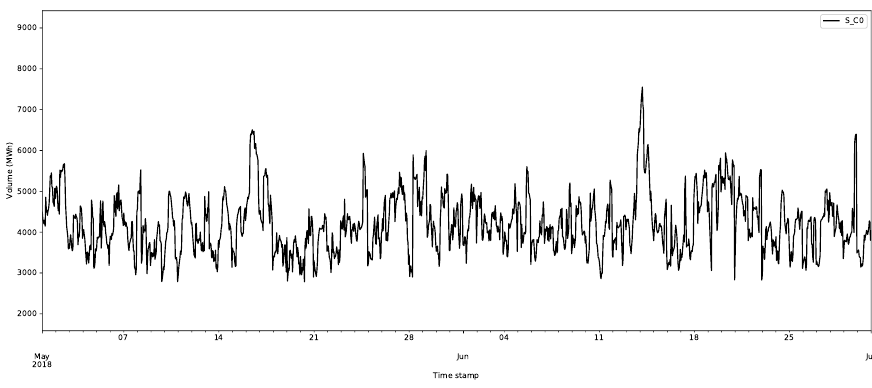
Figure 9. Sample of the volume time series for the first supply